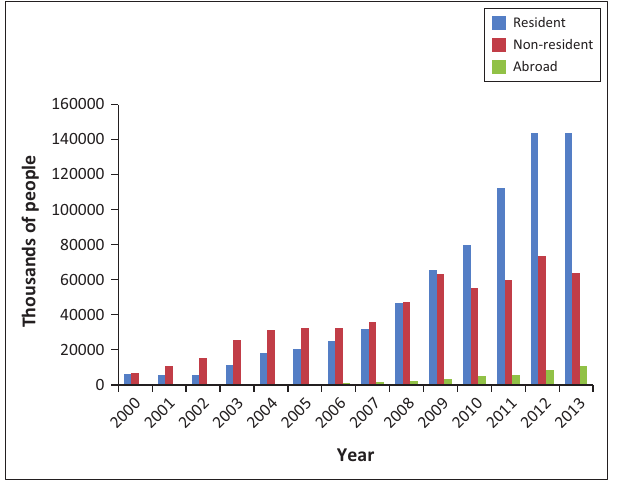
FIGURE 6: Patent grants by source for China (thousands of